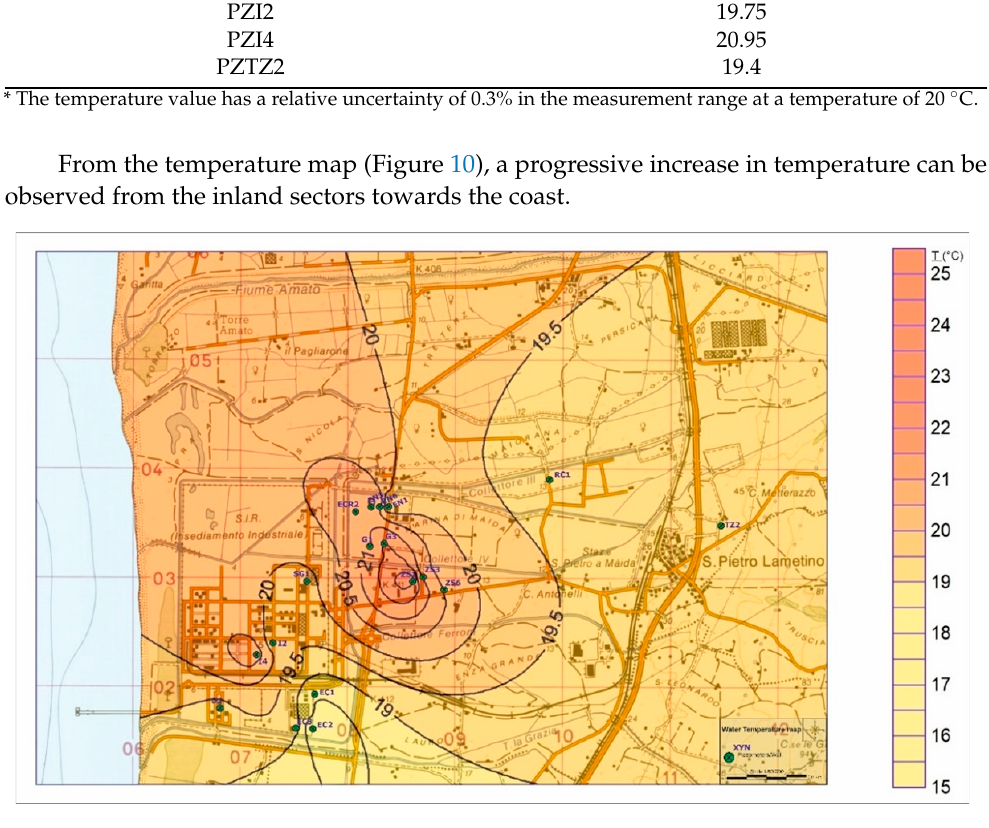
Figure 10. Water Temperature Map in Monitoring Points (Median Values) (Data from